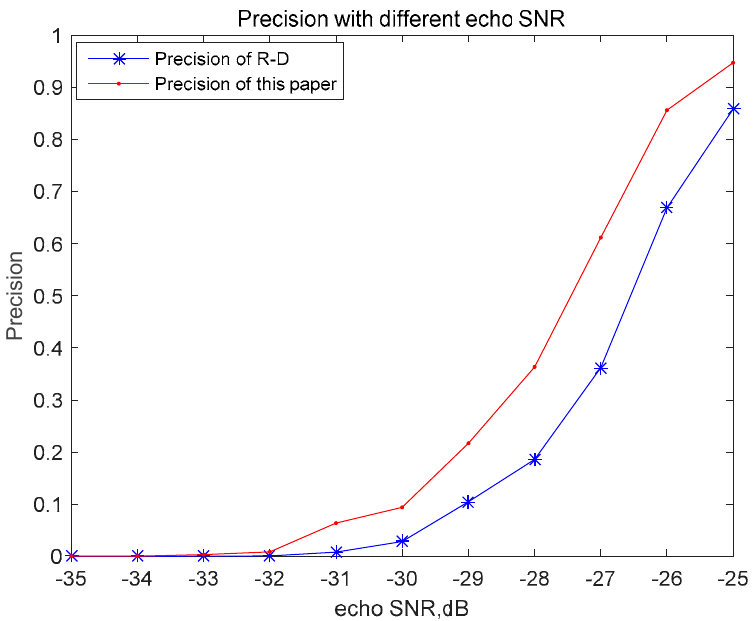
Figure 12. Precision of target detection with different noise power values ( N = 10 4 ): reference SNR = 0 dB.